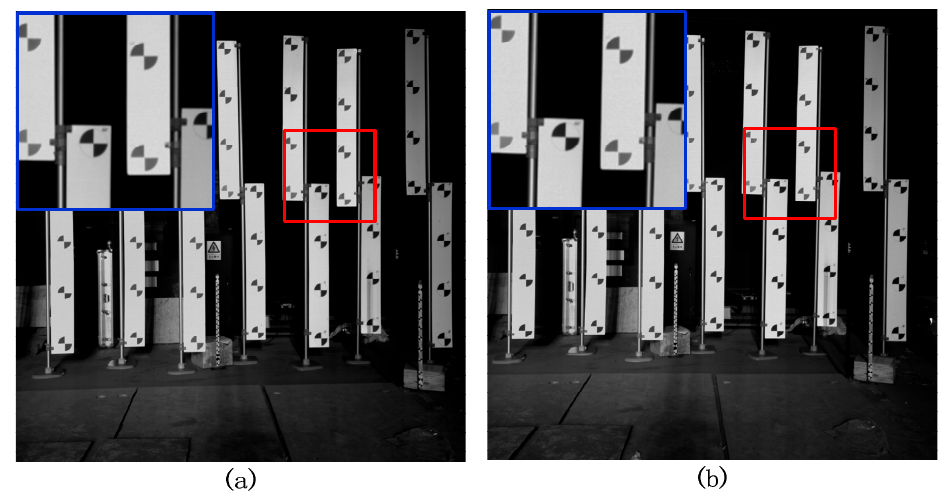
Figure 14. Checkpoints and stereo images (the subgraph is a detailed display of the red square box area on the right. The intersection of two opposite black areas is the corresponding checkpoint. ( a , b ) are the images captured by the left and right navigation cameras).